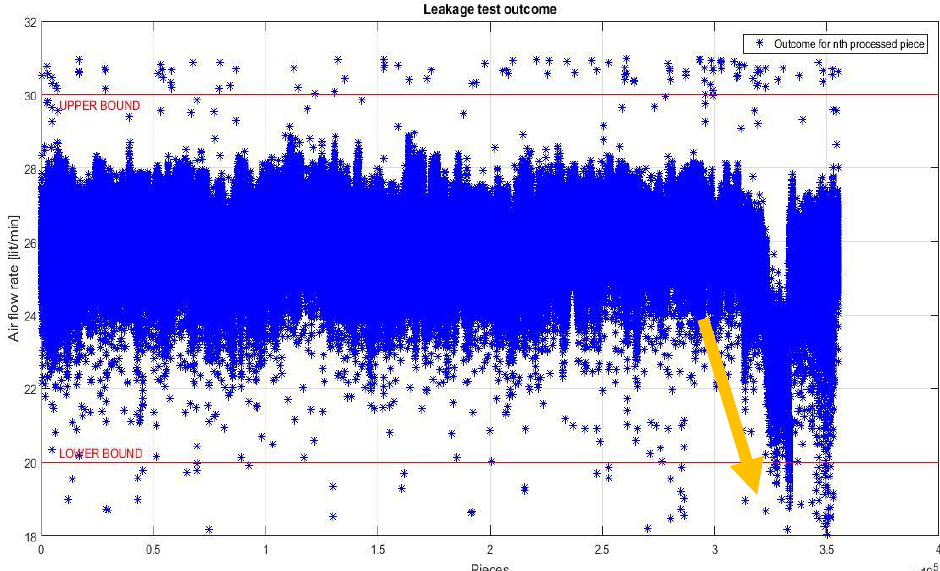
Figure 4. Time series of the air volumetric flow rate measured within a vacuum pump to test presence of leakages. The typical behavior is flat while the peculiar behavior rising at the end of the sequence corresponds to an issue observed in the pneumatic circuit of the